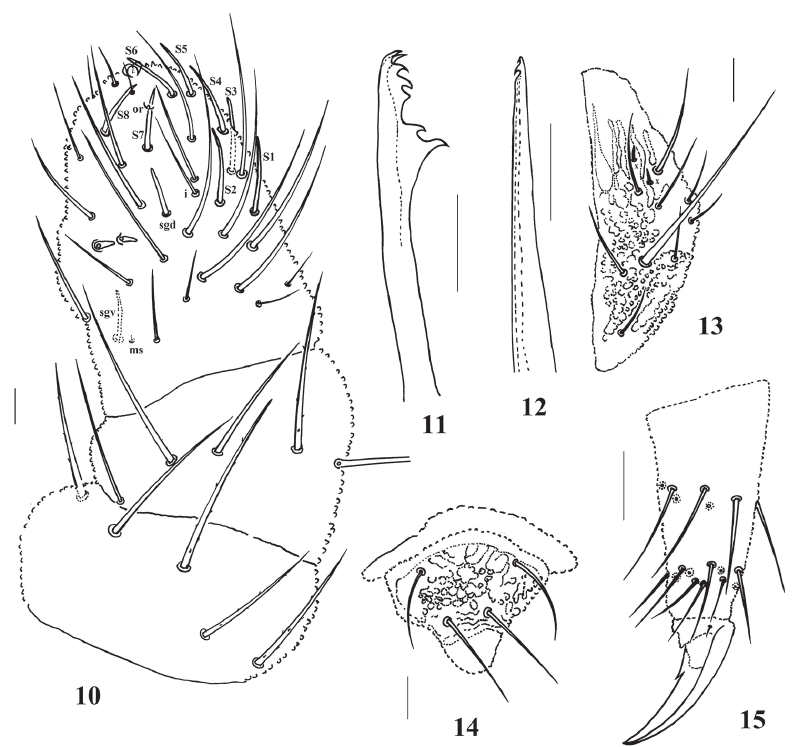
Figures 10–15. Paralobella tianmuna sp. n. 10 Antenna 11 Mandible 12 Maxilla 13 Labium 14 Labrum 15 Tibiotarsus and claw of hind leg. Scale bars: 10–14 20 μm; 15